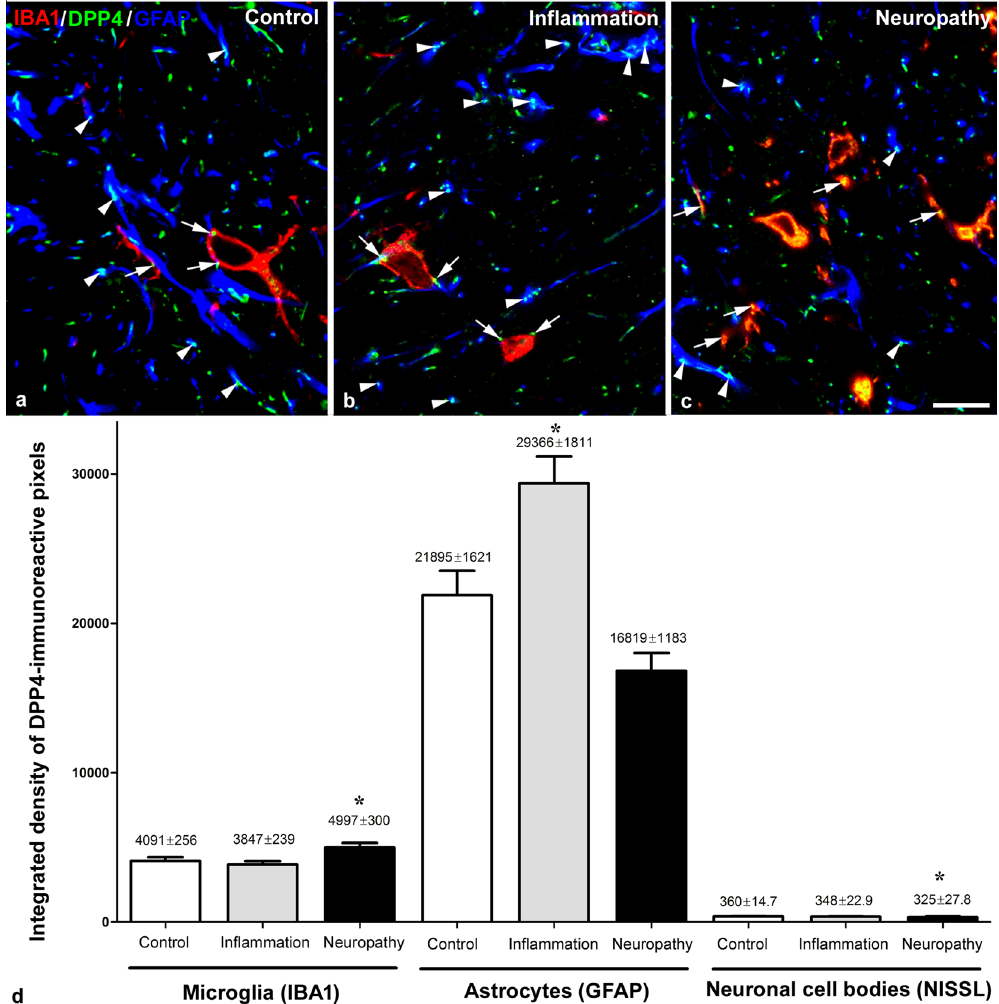
Figure 4. DPP4 immunoreactivity in glial cells in control, inflamed and neuropathic animals. Representative confocal images of the spinal dorsal horn obtained from control ( a ), inflamed ( b ) and neuropathic ( c ) animals demonstrate that DPP4 is expressed predominantly by glial cells (arrows: microglia, arrowheads: astrocytes). All the images are single optical sections. Scalebar: 10 μ m. Integrated density values ( d ) demonstrate that the majority of DPP4-immunopositivity is related to GFAP-labelled astrocytes. A proportion of DPP4 labelling belongs to microgila and very few DPP4 is expressed by neuronal cell bodies. Inflammation significantly increased the DPP4 expression on astocytes but not on the other cell types. In contrast to inflammation DPP4 density was significantly higher on microglia and lower in neurons during neuropathy (Kruskal-Wallis One way ANOVA on ranks, Dunn’s Method, P <